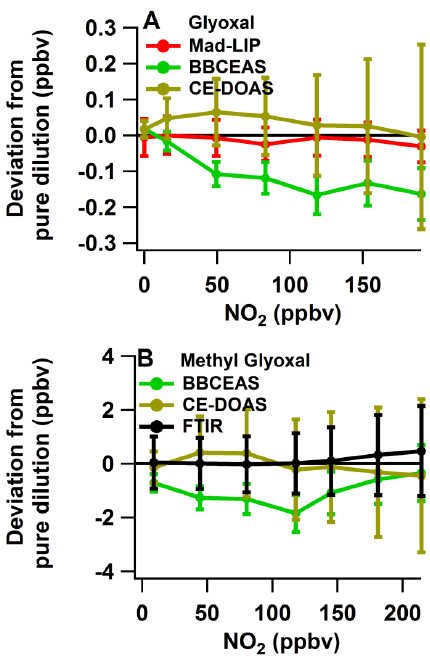
Figure 5. Deviations from pure dilution in the chamber for exper- iments 9 and 10 relative to NO 2 in the chamber. No clear trend is apparent over the full range of NO 2